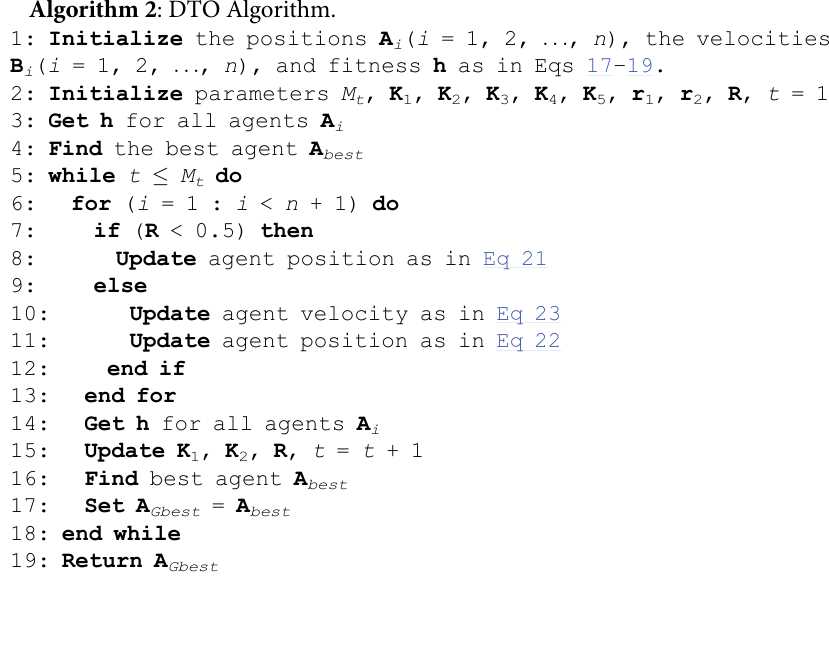
Algorithm 2 : DTO